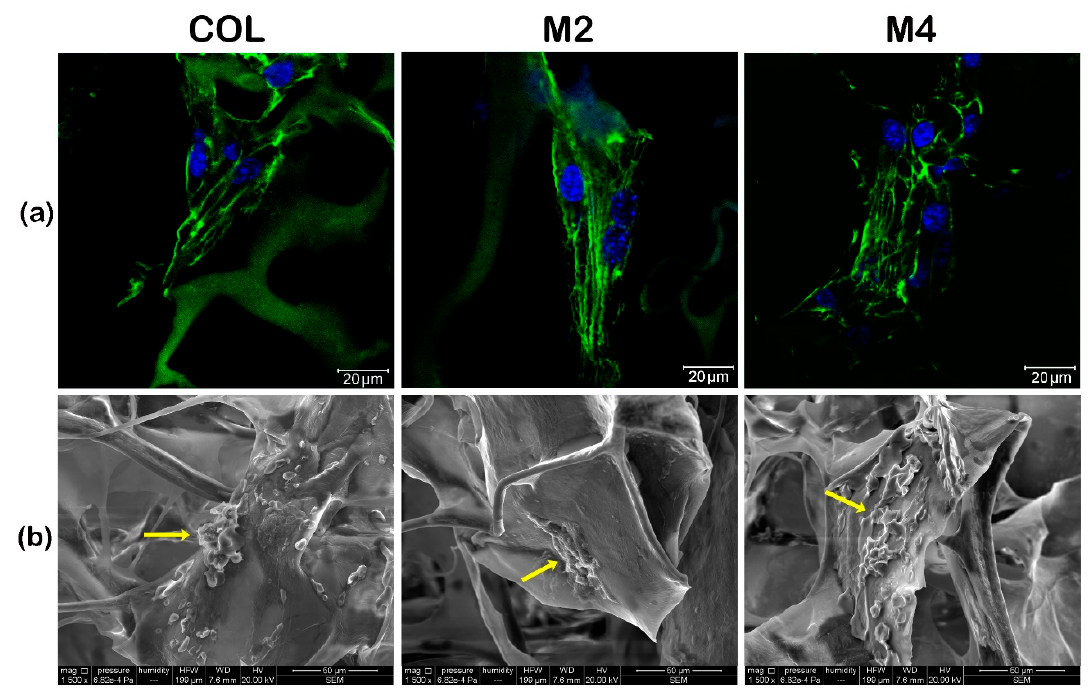
Figure 1. Evaluation of undi ff erentiated hASCs morphology, adhesion and distribution in the 3D materials by: ( a ) confocal microscopy and fluorescent staining; ( b ) SEM (yellow arrows pinpoint the cells attached to the